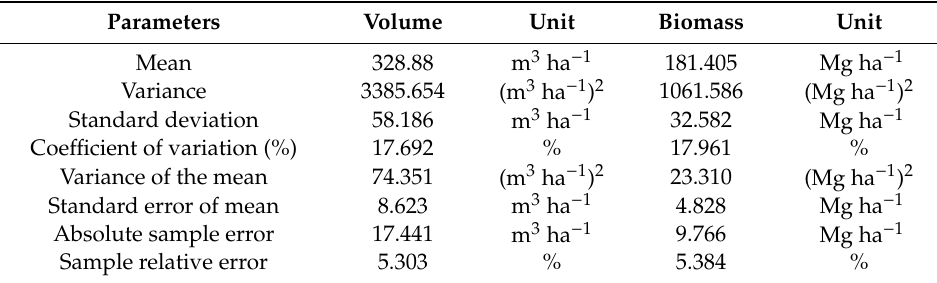
Table 1. Parameters obtained via the forest inventory carried out in eucalypt stands.